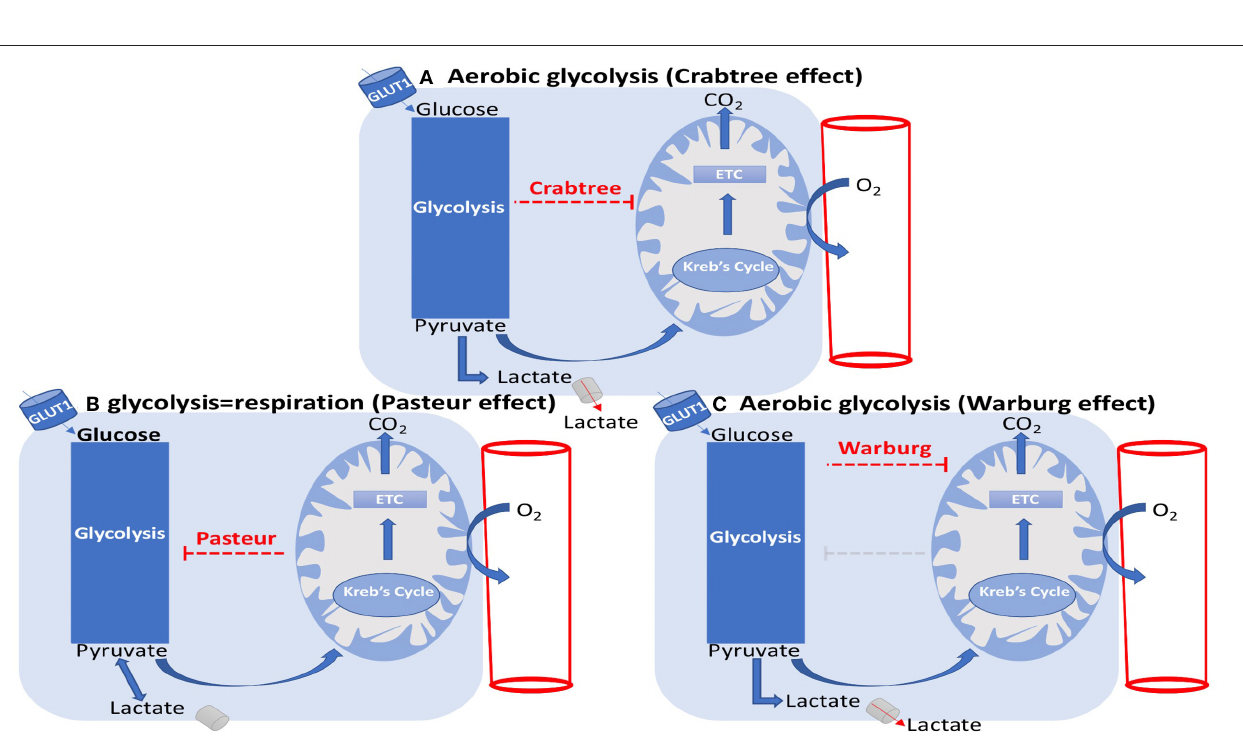
FIGURE 7 | EC metabolism: Crabtree, Pasteur, and Warburg effects. (A) Aerobic glycolysis (Crabtree effect). (B) glycolysis = respiration (Pasteur effect). (C) Aerobic glycolysis (Warburg effect). (A) The Crabtree effect is the enhancement of glycolysis and suppression of mitochondrial respiration, which results in lactate generation. (B) The Pasteur effect is the enhancement of mitochondrial respiration and inhibition of glycolysis. (C) The Warburg effect is the inhibition of oxidative phosphorylation, leading to lactate generation in spite of the presence of oxygen.